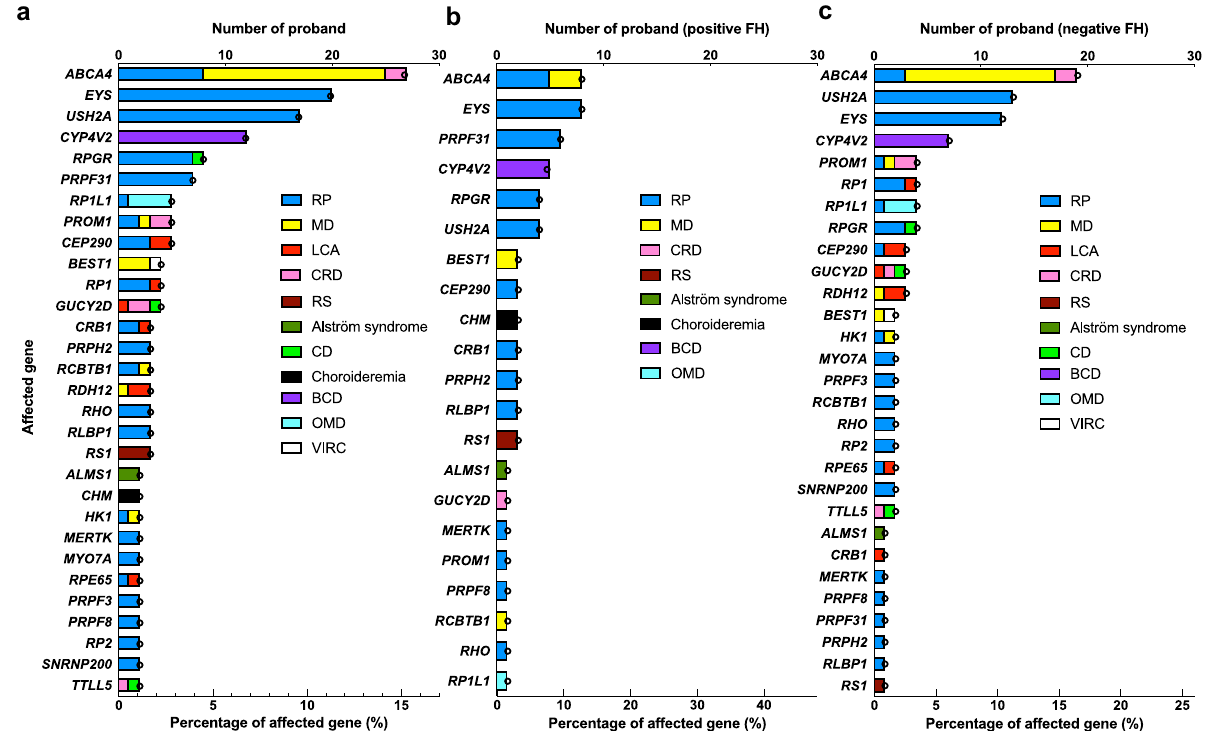
Fig. 3 Number of probands grouped by disease-causing gene, phenotype, and the percentage of disease-causing gene in the probands in our cohort shown by a hollow circle. a Number of probands by disease-causing gene and phenotype, and the percentage of disease- causing genes in 312 probands. Only the disease-causing genes in two or more probands are shown. b Number of probands by disease- causing gene and phenotype and the percentage of disease-causing genes in probands with a positive family history. c Number of probands by disease-causing gene and the phenotype and percentage of disease-causing genes in probands with a negative family history. FH family history, RP retinitis pigmentosa, MD macular dystrophy, LCA Leber congenital amaurosis, CRD cone-rod dystrophy, RS retinoschisis, CD cone